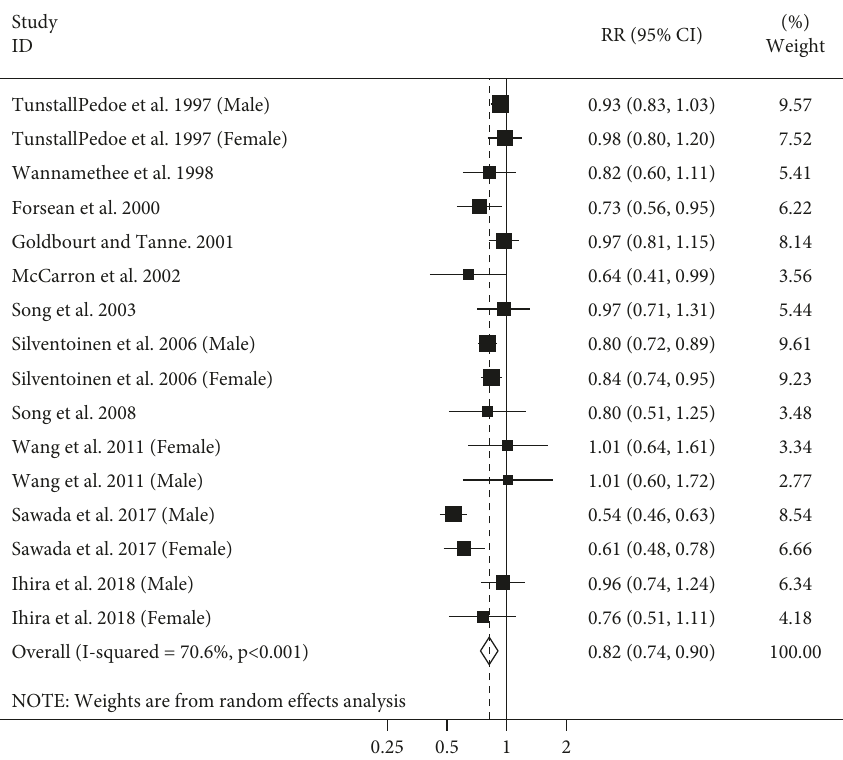
Figure 3: Forest plot for the association between adult height and CHD mortality by considering the highest and lowest height. Horizontal lines represent 95% CIs. Diamonds represent the pooled estimates from the random-effects analysis. RR: relative risk; CI: confidence interval.